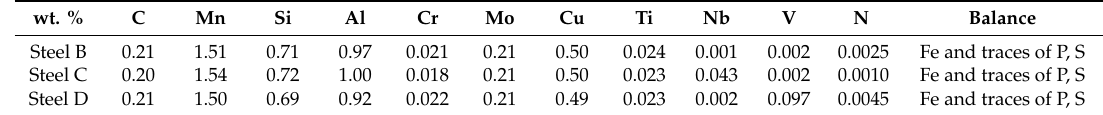
Table 2. Elemental compositions in weight percentage of the experimental laboratory steels. wt.